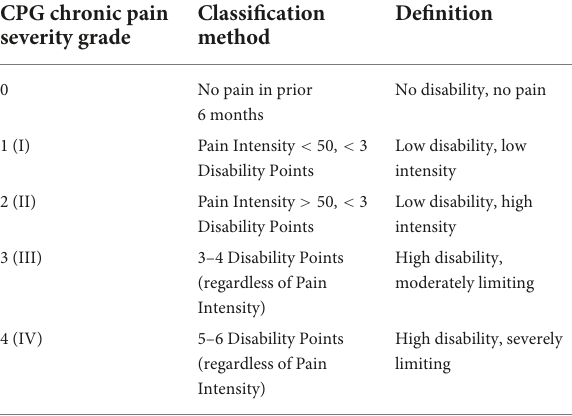
TABLE 1 Pain severity grade according to CPG. TABLE 2 Baseline demographic variables among participants